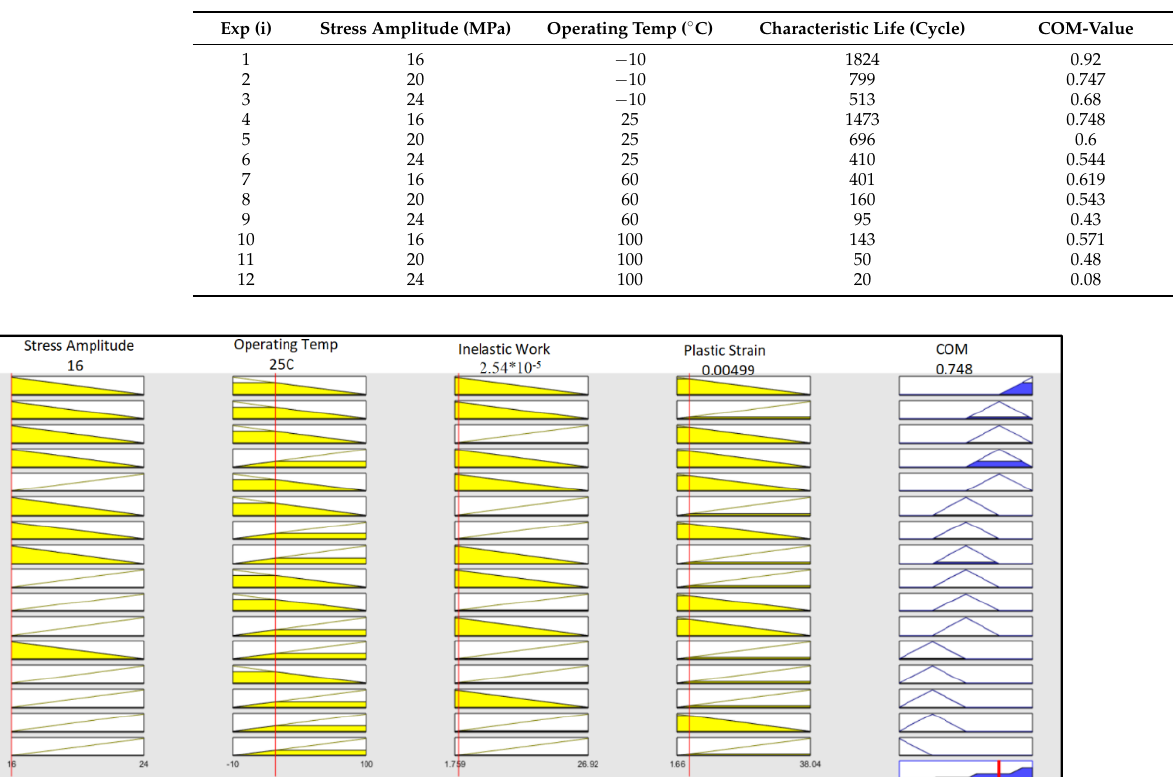
Table 5. COM-Value at each experimental combination with characteristic life values.